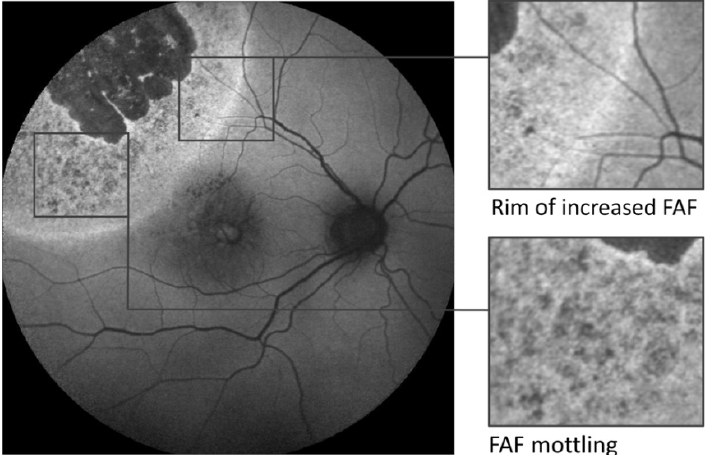
Figure 6. Central fundus autofluorescence image (excitation wavelength 488 nm) taken 45 months after ruthenium-106 brachytherapy (CCA plaque, Bebig GmbH, Berlin Germany; scleral dose 460 Gy) of a choroidal melanoma in a 52-year-old male. Areas with atrophy of the retinal pigment epithelium overlying the irradiated melanoma apex appear dark, whereas the farther irradiation field shows an inhomogeneous increased fundus autofluorescence signal with small, speckled areas of decreased autofluorescence (mottling). Furthermore, a rim of considerably increased autofluorescence clearly delineates the irradiation effect on retinal layers that contribute to the autofluorescence signal. The fundus autofluorescence image was taken using SPECTRALIS HRA+OCT, Heidelberg Engineering, Heidelberg, Germany. Reproduced from Bindewald-Wittich et al. [91] with permission from S. Karger AG, Basel.